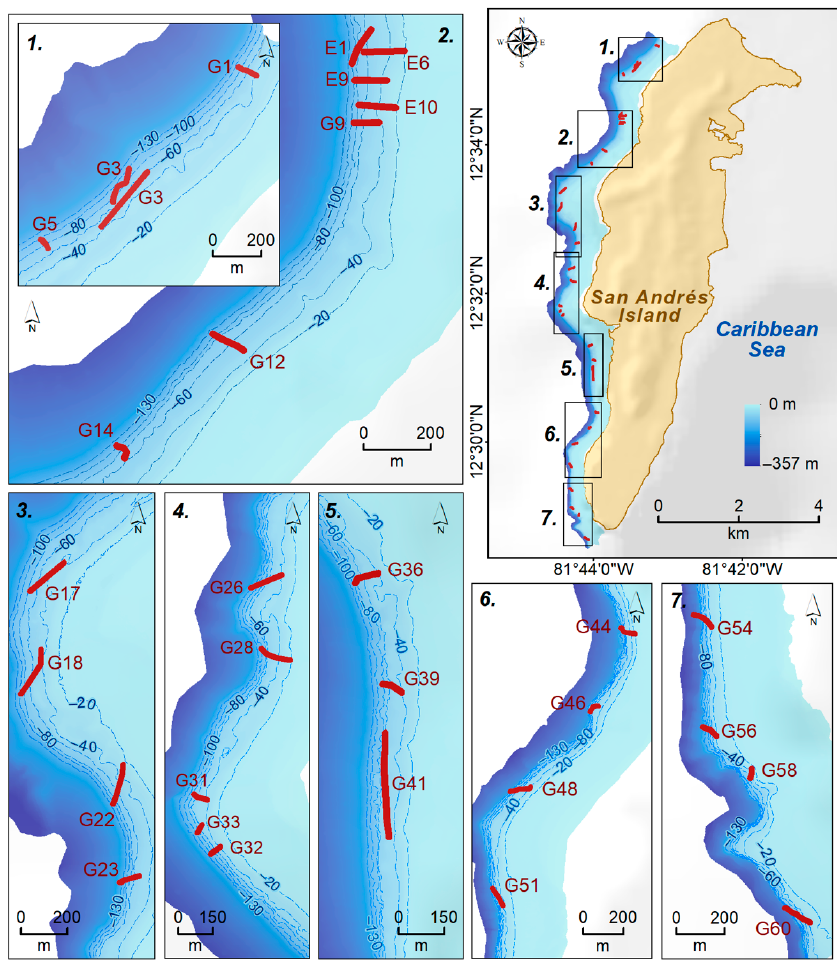
Figure 2. Location and name (G_number and E_number) of the video transects (red lines) made along the western side of San Andrés Island, Colombian